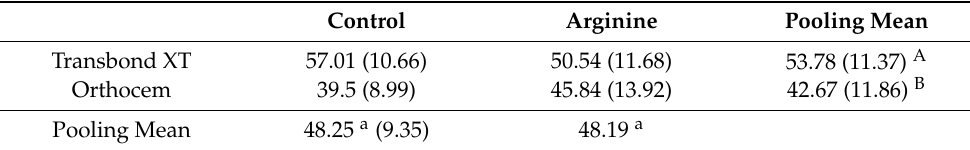
Table 3. Mean values and standard deviation (MPa) of UTS of the tested materials.